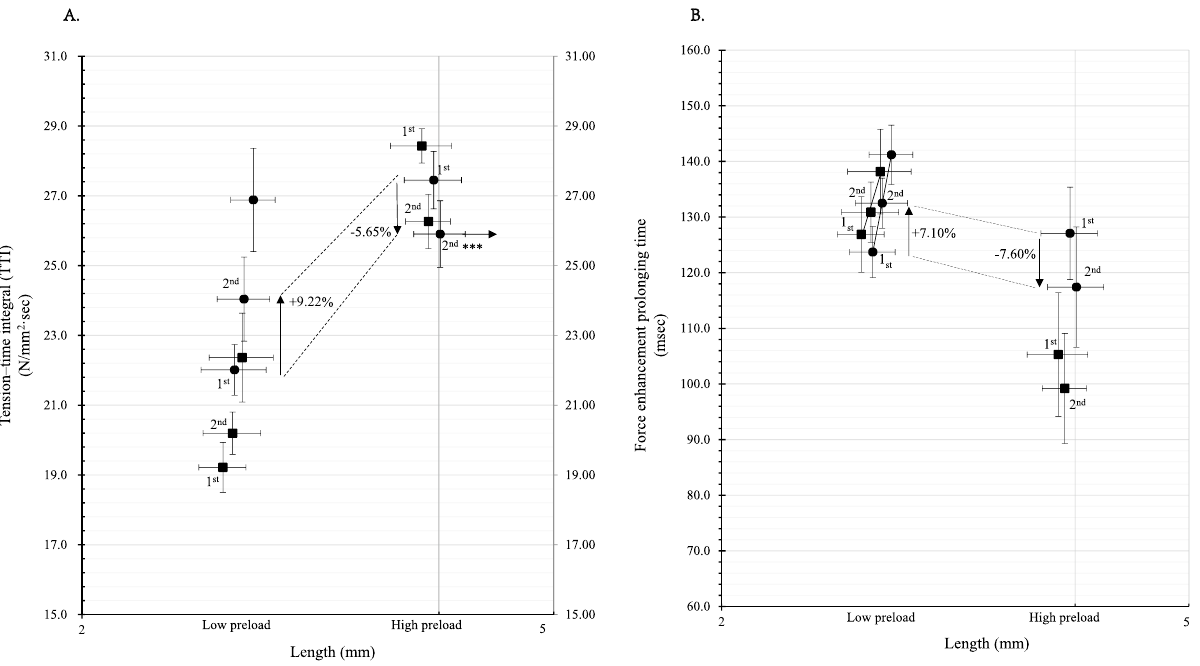
Figure 4. Force enhancement tension-time integral in excessive preload cardiac fibres. ( A ) The tension– time integral (TTI) of the force enhancement throughout the preload range of cardiac fibres. In intact fibres (black dots, n = 10), the TTI was significantly increased in the high preload range; however, the 2nd TTI was significantly reduced (5.65%) because of the shortening of the prolonging time (t 2 ). These differences presented in shed fibres as well (n = 10). However, in low preload fibres, the adjacent stretch induced an increase in TTI increasing (3rd 10.57% increase). ( B ) The force enhancement prolonging time throughout the preload range of cardiac fibres. In intact fibres (black dots), t 2 was significantly shortened in the high preload range (5.78% shortened, n = 10); however, in the low preload range, the last stretch-induced t was extended (6.56% increased, black dots, n = 10). These differences presented in shed fibres as well (black square, n =